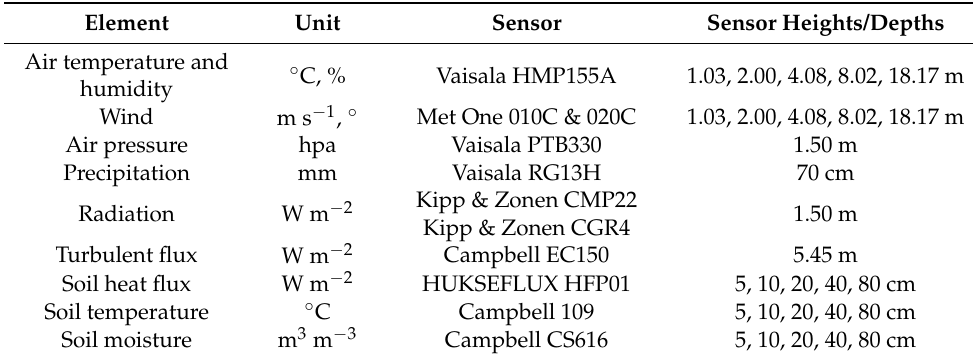
Figure 1. ( a ) Geographic location of the Shiquanhe site. ( b ) Underlying surface and sensors. ( c – h ) Time series of wind speed, wind direction, air temperature, specific humidity, air pressure, and precipitation at Shiquanhe from 1 September 2013 to 1 September 2015, respectively. Table 1. Meteorological elements and information on related